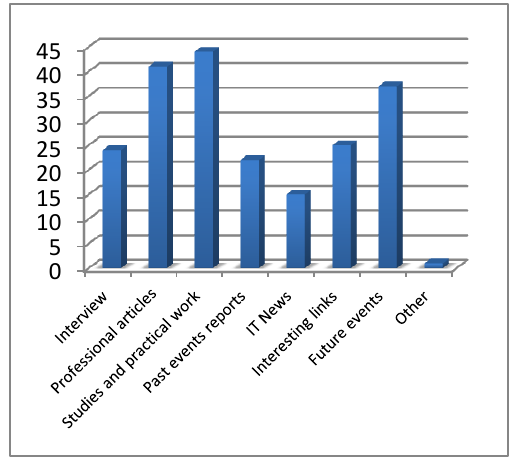
Figure 3. Graph showing the respondents’ answers to the question on which part of the SC Newsletter is the most interesting for